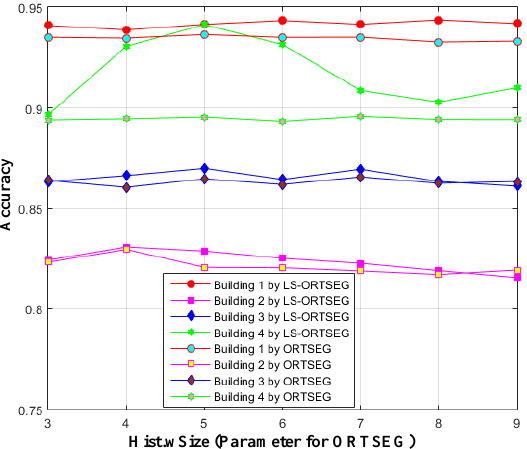
Figure 12. Accuracy using different window sizes. The ‘NumTextures’ are set to 5 for ORTSEG, and ‘Hist.wSize’ are set from 3 to 9 for both ORTSEG and LS-ORTSEG.